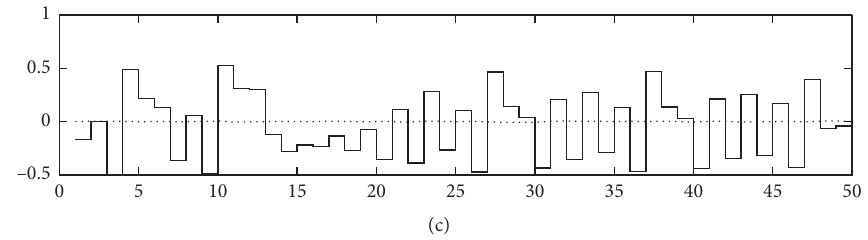
Figure 2: Synchronization of discrete-time chaotic system with (a) x